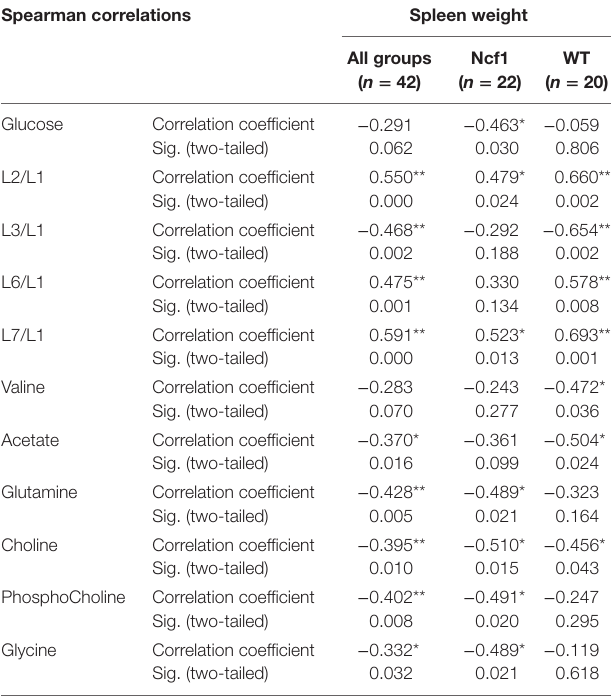
TaBle 6 | Summary of all statistically significant Spearman correlations for spleen weight vs metabolites concentrations considering either all mice pooled together or Ncf1-mutant (Ncf1) vs wild-type (WT) groups. spearman